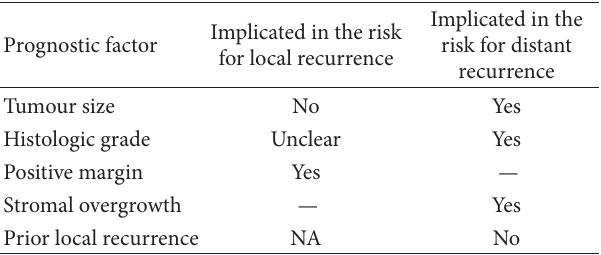
Table 2: Prognostic factors implicated in the risk for distant and local recurrence in phyllodes